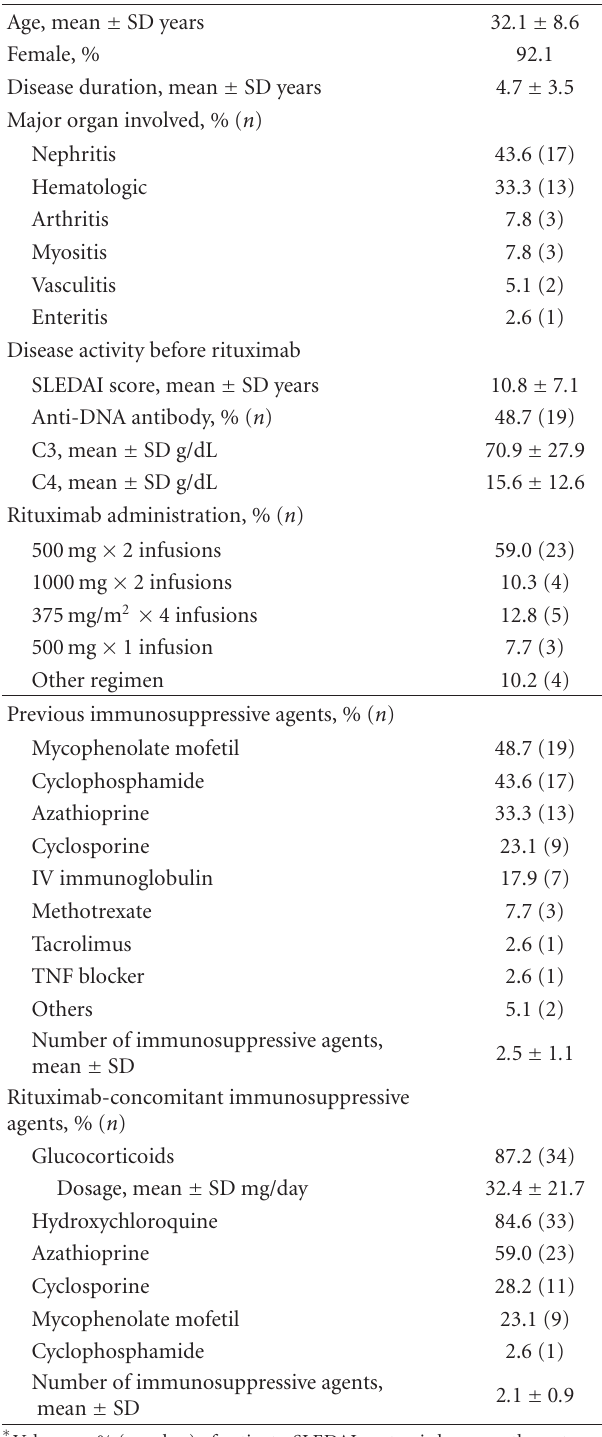
Table 1: Characteristics of the 39 SLE patients receiving